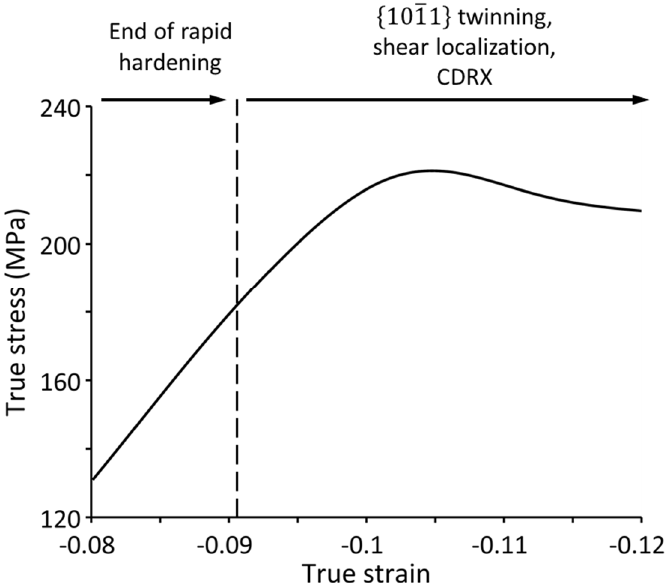
Figure 22. Transition from rapid work hardening to a steady state of C-oriented pure Mg crystals as in Figure 9 (red curve). The curve shown is a Gaussian fit (goodness-of-fit R 2 = 0.9997) to the measured data.